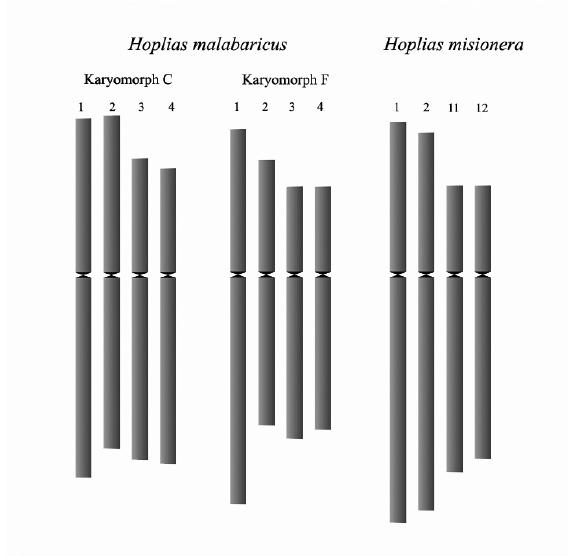
FIGURE 6 | Partial idiogram of the four largest chromosome pairs of Hoplias malabaricus (karyomorphs C and F) and H. misionera showing marked size reduction from the first to second metacentric pair only in the karyomorph F.